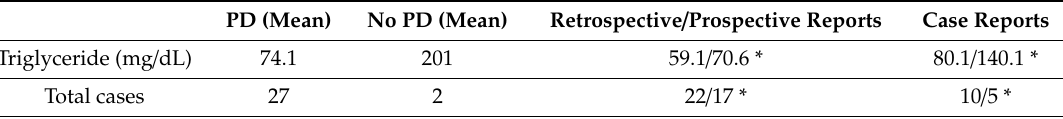
Table 3. Triglyceride (chylous ascites / e ffl uent) levels of all patients.